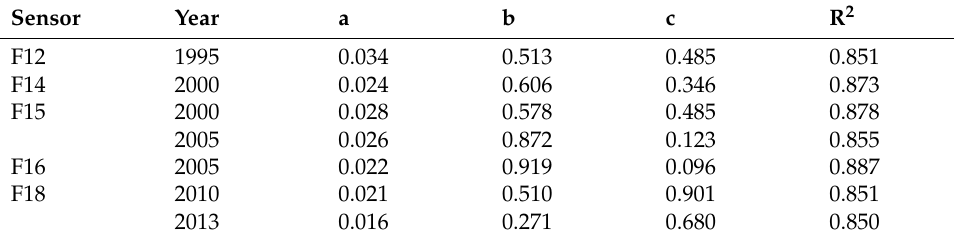
Table 2. Parameters of a quadratic equation with one variable provided by Lu [79].